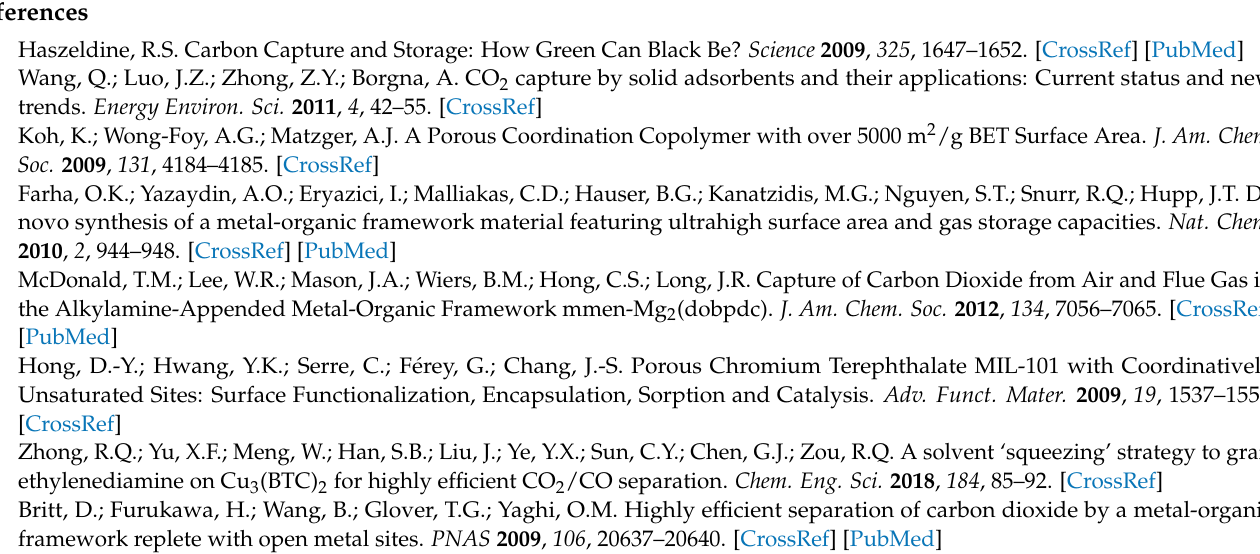
Figure S2: Enlarged the PXRD patterns of simulated CuBTC for 6 times in 2 T > 13 range. Figure S3: XRD of CuBTC-Water after water stability test. Figure S4: BET fitting plot of CuBTC-DMF. Figure S5: BET fitting plot of CuBTC-Water. Figure S6: Enlarged pore distributions of CuBTC-DMF and CuBTC-Water calculated by using NLDFT method. Figure S7: Adsorption enthalpies of (a) CO 2 and (b) N 2 for CuBTC-DMF and CuBTC-Water. Table S1: Comparison of the other reported numbers for CuBTC in literature